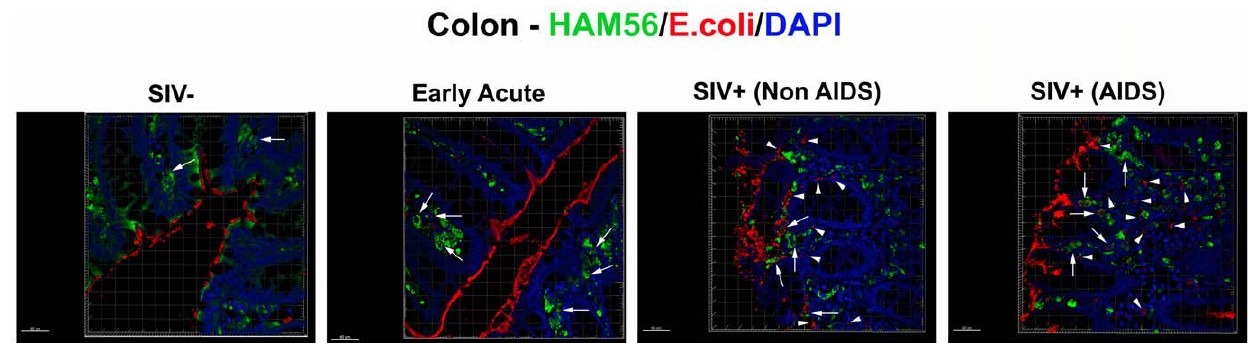
Figure 10. Microbial products are differentially phagocytosed in acutely and chronically SIV-infected RMs. Confocal immunofluorescent 3-D images of colon (400 6 ) stained for HAM56 (macrophages; green), E. coli (red) and DAPI (nuclei; blue) showing the progressive decrease in the fraction of microbial products ( E. coli , red) internalized by macrophages (green, highlighted by white arrows), and an increase in the proportion that were not cell associated with progressively more severe SIV infection. For specimens obtained from animals with later stages of infection, the presence of abundant HAM56 + macrophages (green) without internalized E. coli constituents (red) (highlighted by white arrow heads), despite extensive E. coli constituents present in the LP near macrophages, suggests that macrophages in chronic SIV + RMs become less able to efficiently clear microbial products translocated into the LP. Rare microbial constituents are present in SIV-uninfected RMs but are virtually always found within macrophages. Scale bars =40 m